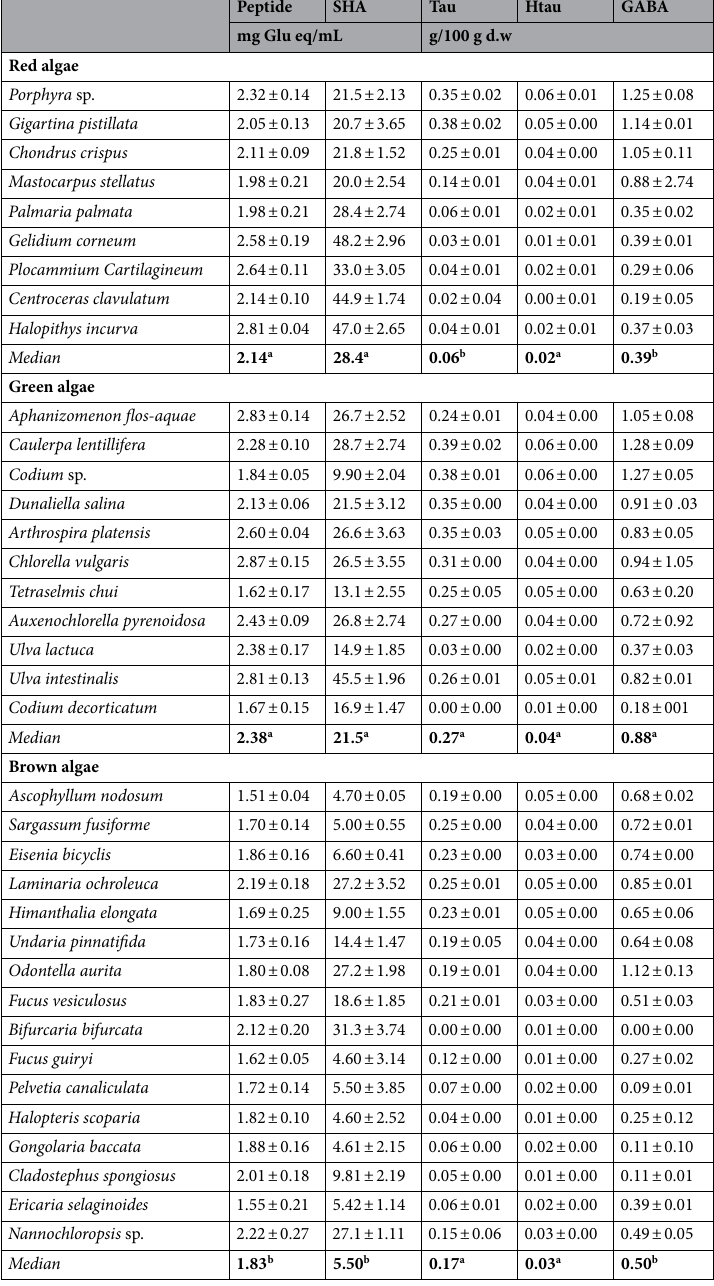
Table 2. Peptide, sum of hydrophobic amino acids (SHA), Taurine (Tau), Homotaurine (Htau), and Gamma- aminobutyric acid (GABA) content in enzymatic protein hydrolysates (EPH) from the 36 algae species studied (mean of n = 3 independent determinations ± SD) Significant values are in bold. Different small letters in the same column indicate significant differences between medians of the algae groups ( p <